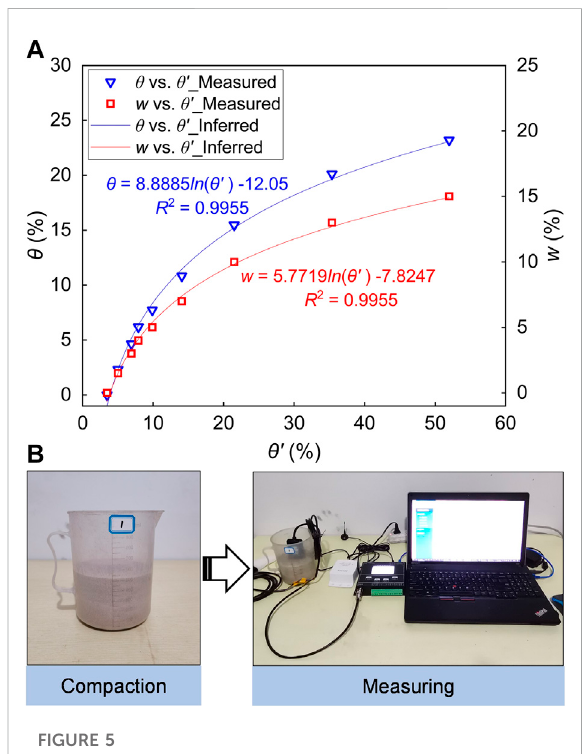
FIGURE 5 (A) Relationshipbetweenthevaluemeasuredbythemoisture sensor ( θ ′ ) and actual volumetric water content ( θ ) and mass moisture content ( w ) of similar materials, and (B) Schematic of the moisture content sensor calibration